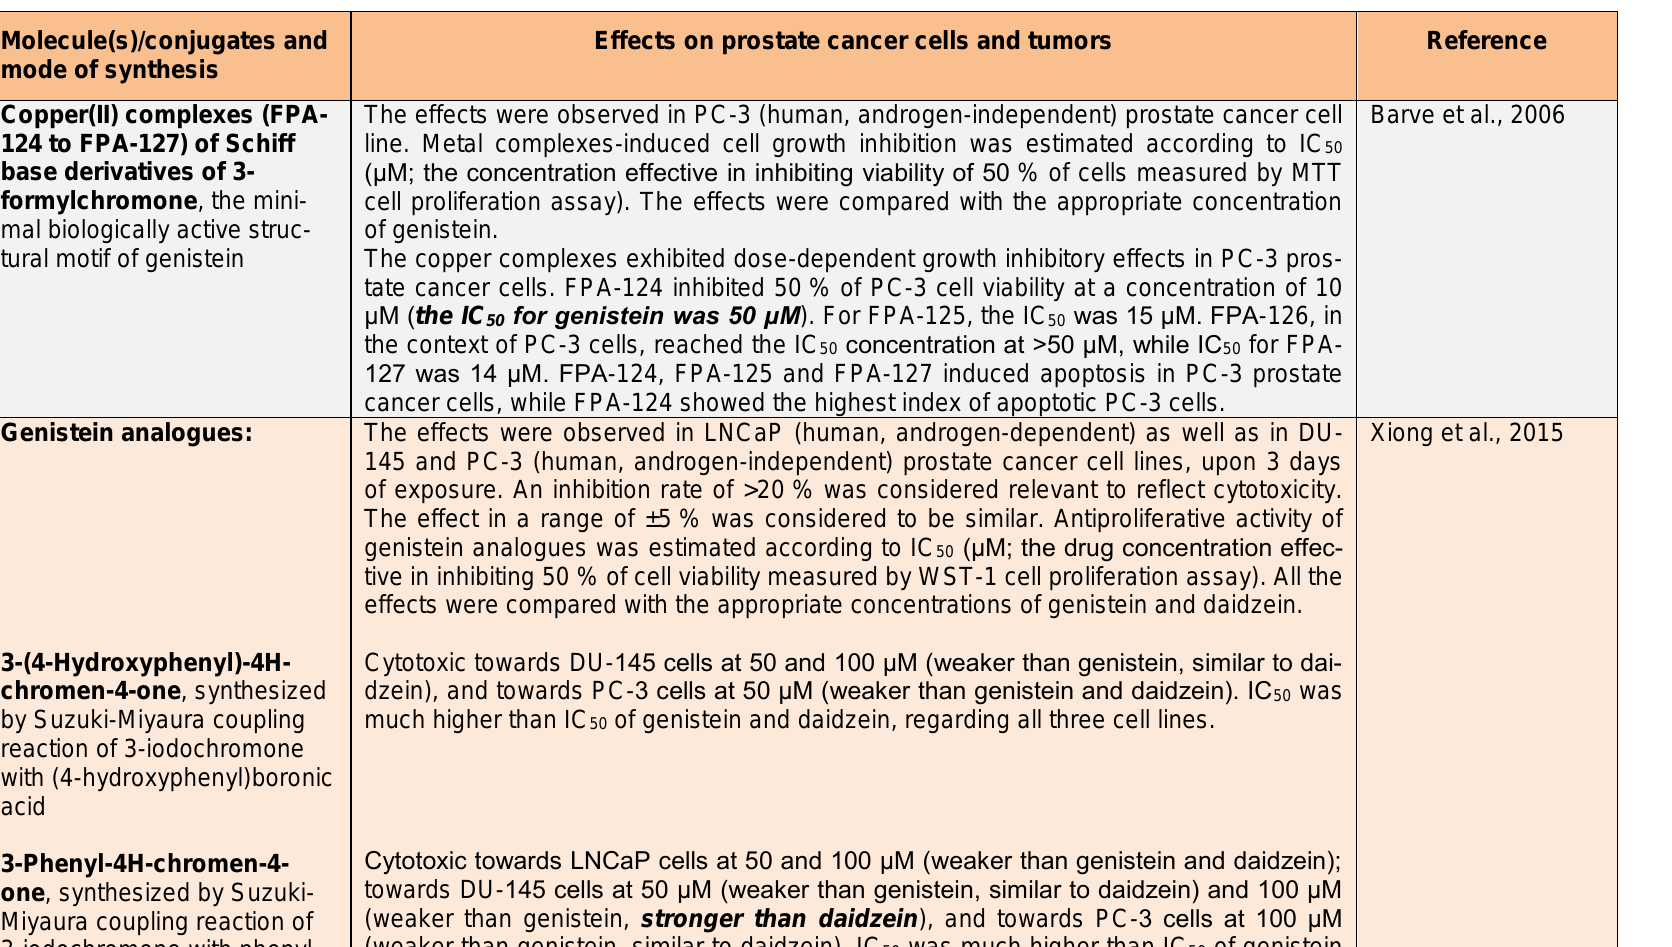
Table 1: A review of interventions on soy isoflavone molecules that have been performed to improve their therapeutic potential for prostate cancer